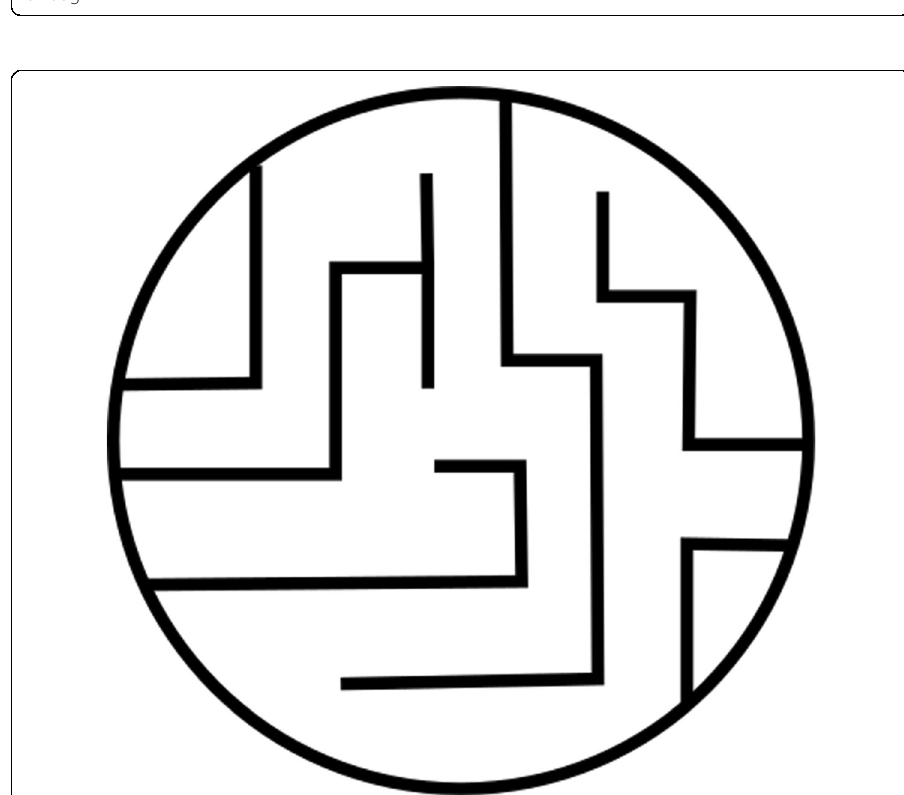
Fig. 9 Legend: The unpredictable and discontinuous connections are illustrated through the maze-like